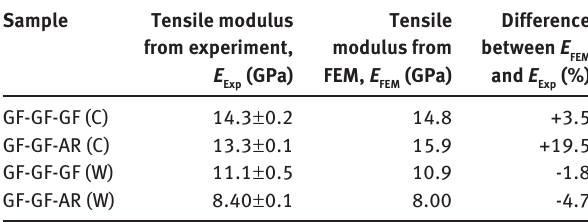
Table 8 Tensile modulus from FEM and from experiments.